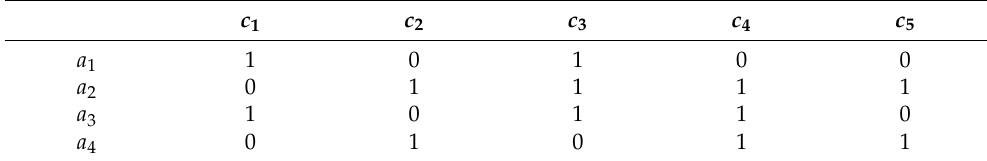
Table 2. A information system of soft